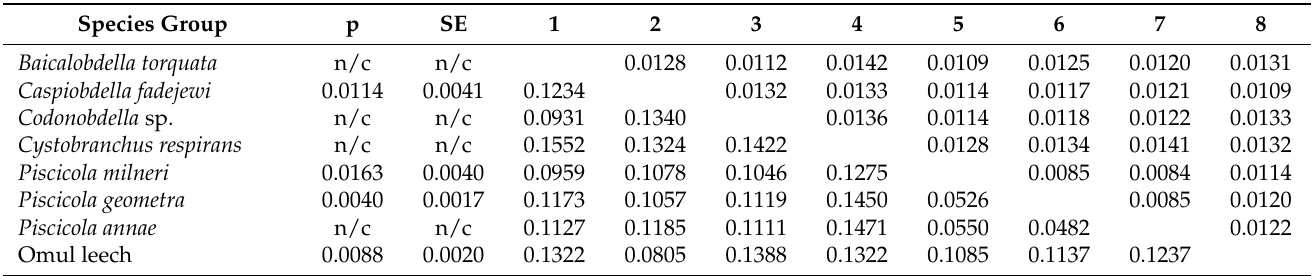
Table 3. Net evolutionary divergence (p) within and between selected sequences of groups of freshwater